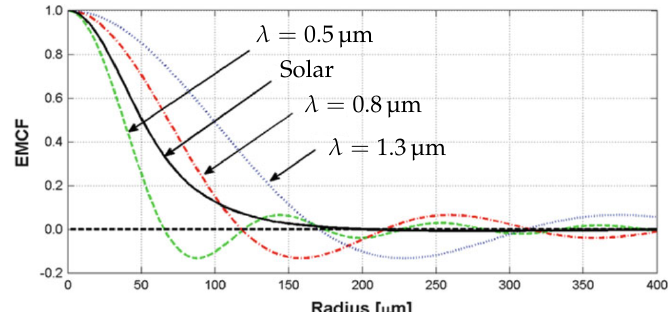
Figure 10. Equal time mutual coherence function (EMCF) function curve for the quasi-monochromatic light for wavelengths λ = 1.3µm,0.9µm,0.5µm and for solar black body radiation (Adapted with permission from [34], Springer,